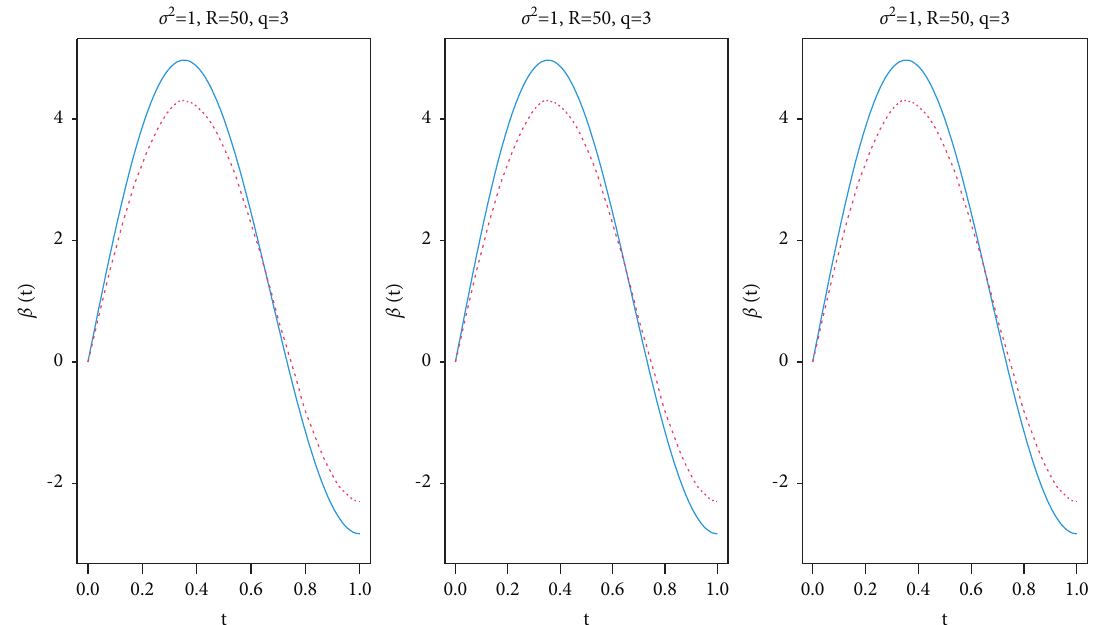
Figure 3: The estimated functional coefficient versus true value of β ( t ) with different ρ s (from left to right responding to ρ � 0 . 5 , 0 , − 0 . 5) when R � 50 ,q � 3 , and σ 2 � 1.